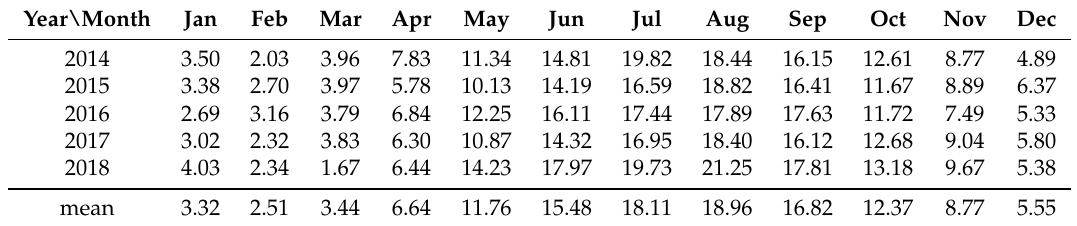
Figure A4. Time series of surface water temperature on station T14 compared with VIEP observations and NEMO-Nordic model. Table A1. Monthly means for surface temperature for the years